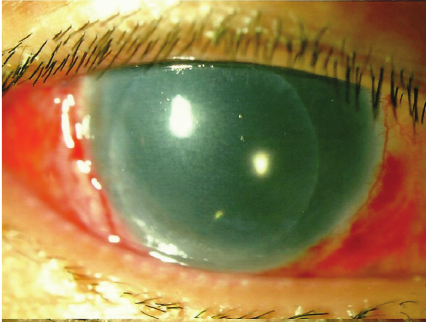
Figure 1: Corneal oedema without EK button.